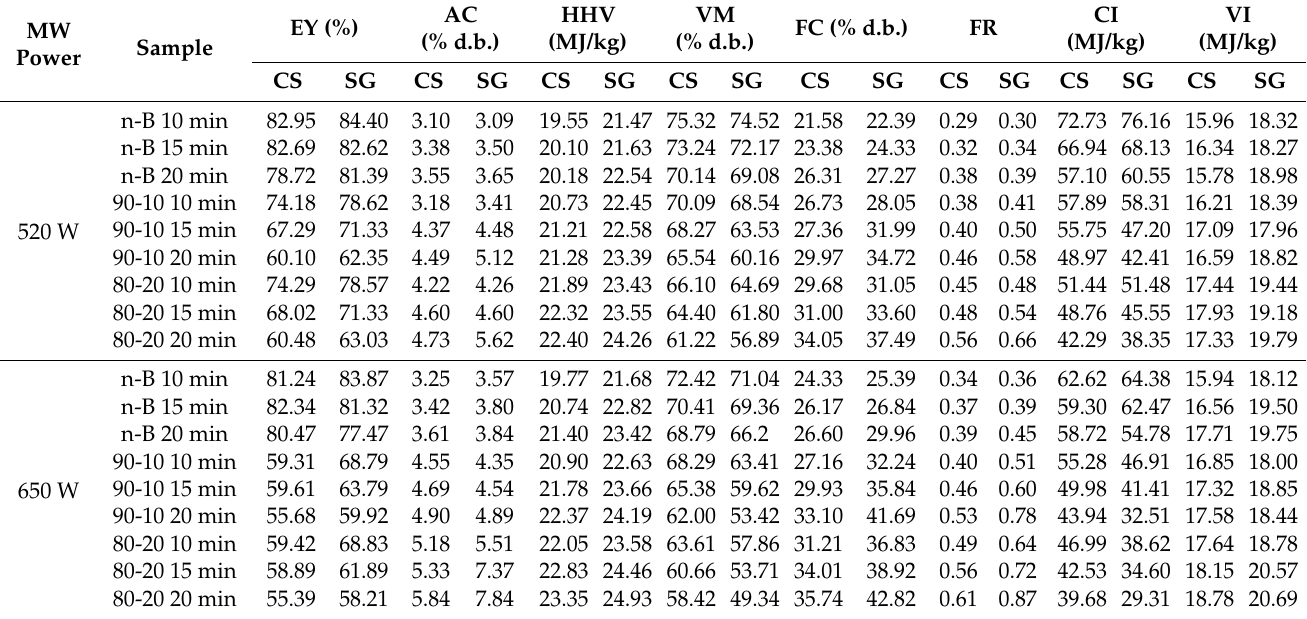
Table 3. Energy yield and fuel properties of torrefied camelina straw and switchgrass with and without biochar added at different microwave power